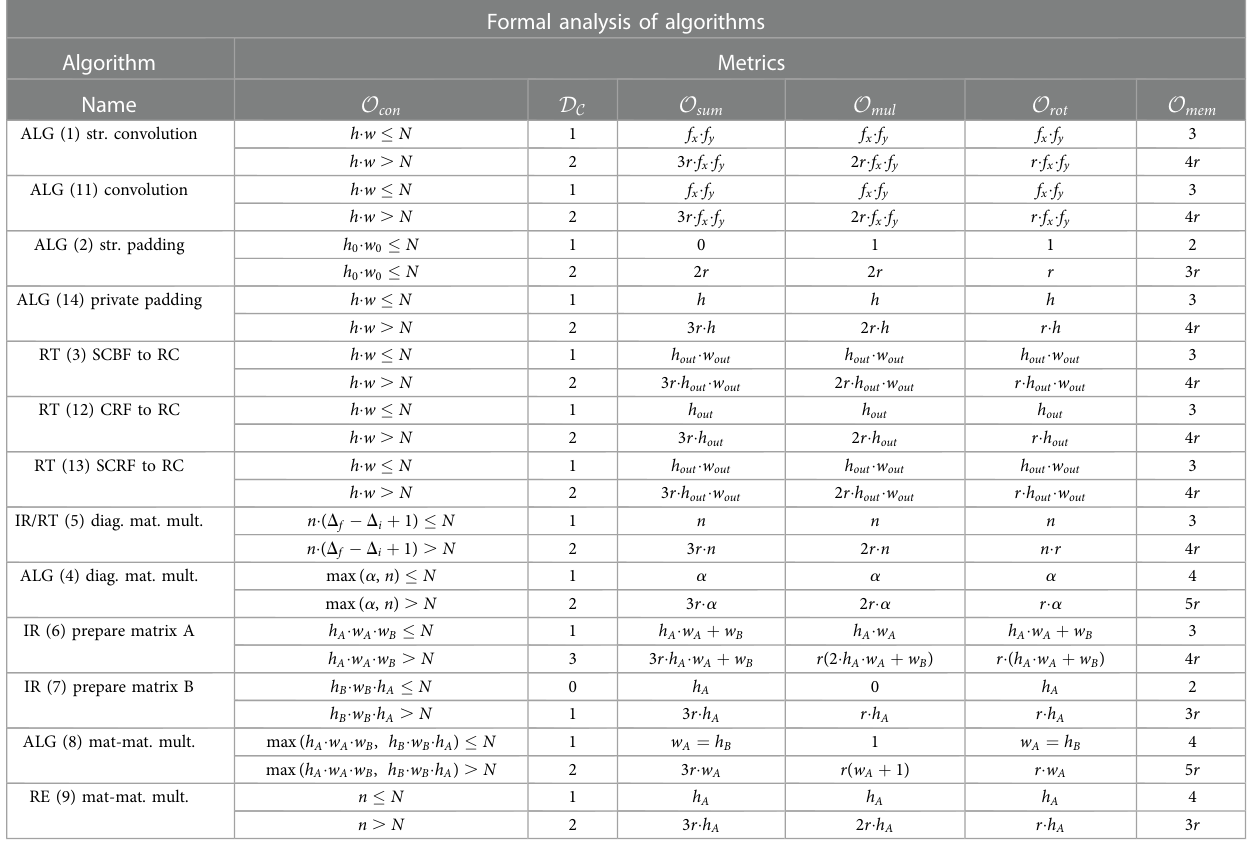
TABLE 2 Detailed analysis of the different metrics proposed in Section 4.1 ( O con , D C , O sum , O mul , O rot and O mem ). Additionally, it shows the performance variation if Rotations are as in Algorithm 10. Formal analysis of